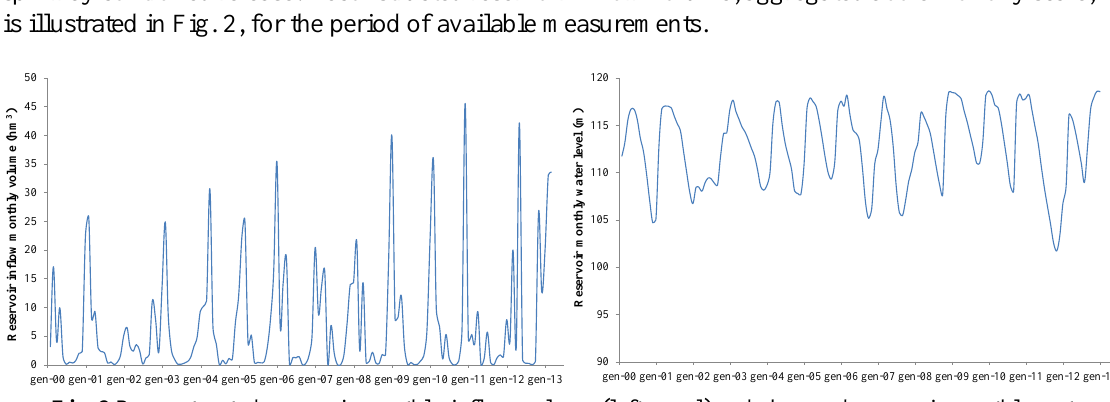
Fig. 2 Reconstructed reservoir monthly inflow volume (left panel) and observed reservoir monthly water level (right panel) for the available measurements